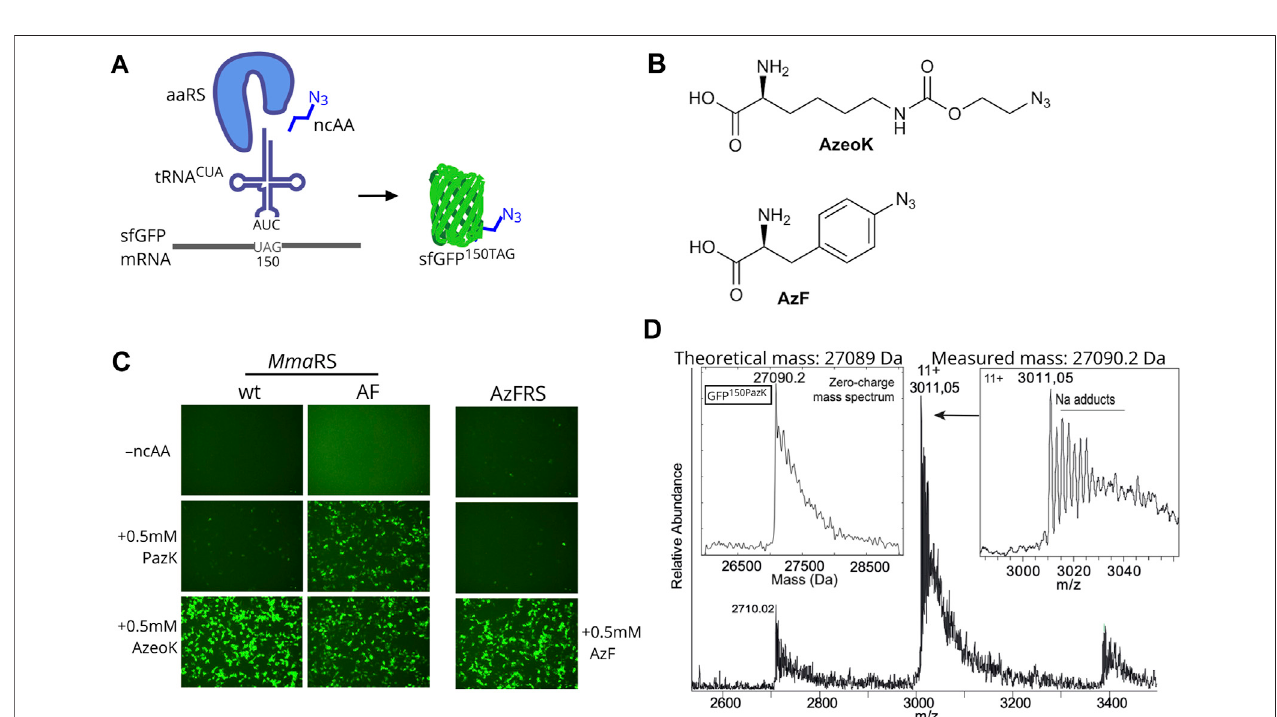
FIGURE 2 | Amber suppression mediated PazK incorporation into protein in mammalian cells. (A) Schematic depiction of noncanonical amino acid (ncAA) incorporation into GFP. Expression of an orthogonal tRNA and aaRS pair allows incorporation of ncAAs with azide side chains into the GFP reporter in response to an amber codon (UAG in the mRNA). (B) Chemical structures of (S)-2-amino-6-[(2-azidoethoxy)carbonylamino]hexanoic acid (AzeoK) and 4-azido-L-phenylalanine (AzF). (C) Live-cell imaging of HEK293T cells transfected with Methanosarcina mazei pyrrolysine-tRNA/RS ( Mma PylT/RS) wt, Mma PylT/RS AF, or Bacillus stearothermophilus ( Bst ) TyrT/AzFRS and cognate tRNA/GFP150TAG reporter plasmid (1 + 4 ratio) in the absence ( – ncAA) or presence of 0.5 mM of the indicated ncAA. Images were taken 24 h posttransfection. (D) Intact mass determination of puri fi ed GFP containing 150PazK (incorporated with Mma PylRS AF in GFP150TAG).